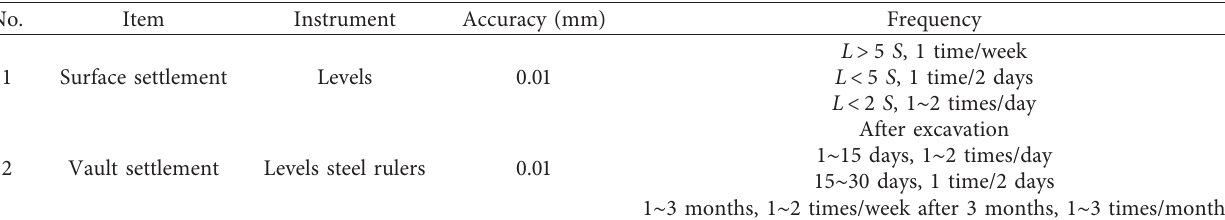
Table 2: Monitoring items and